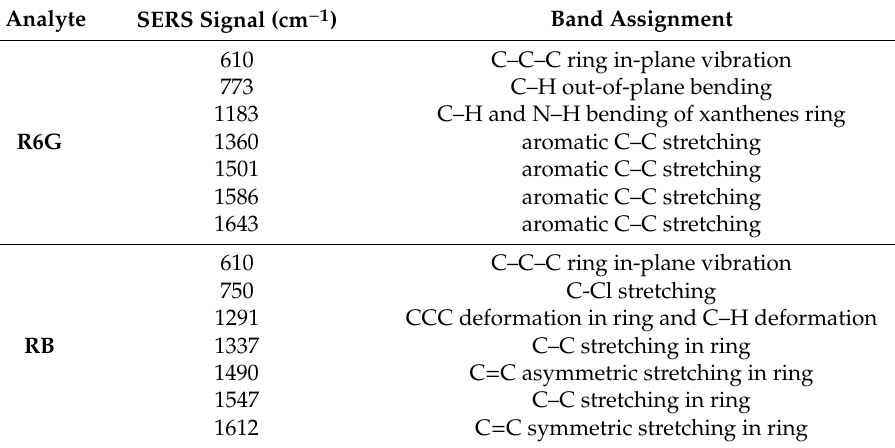
Table 1. Vibrational mode assessments for SERS bands recorded in Figure